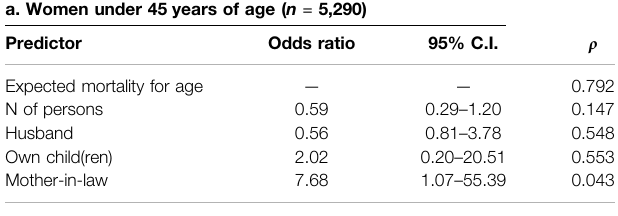
TABLE 2 | Results of two logistic regressions assessing the apparent impacts of other household members on the mortality of women in two age groups, during a 14 month period beginning on January 1,